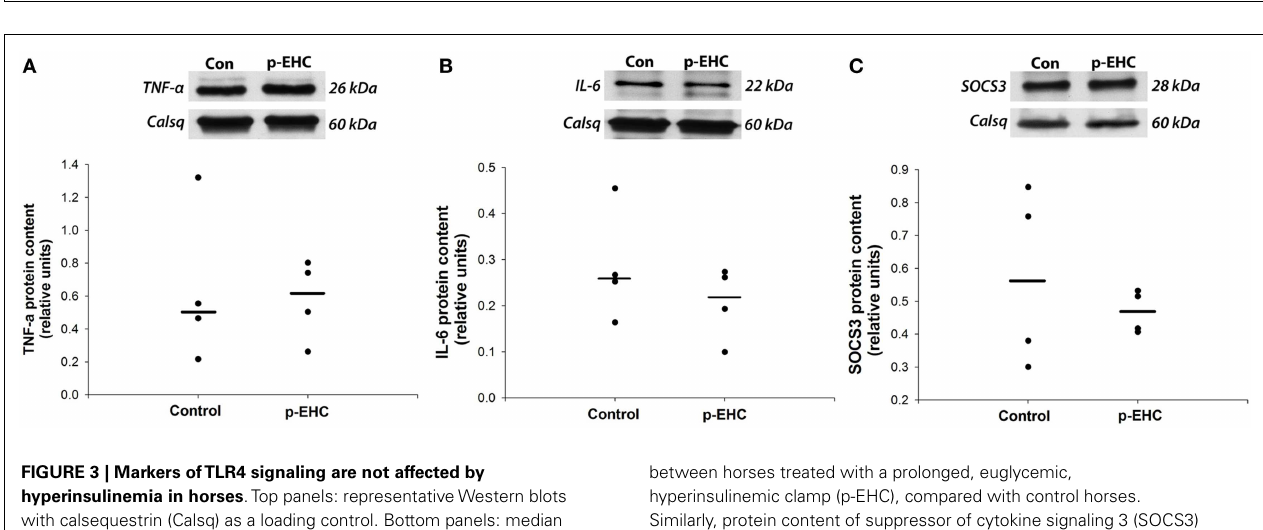
FIGURE 3 | Markers ofTLR4 signaling are not affected by hyperinsulinemia in horses .Top panels: representativeWestern blots with calsequestrin (Calsq) as a loading control. Bottom panels: median myocardial protein expression of the pro-inflammatory cytokines tumor necrosis factor-alpha (TNF- α ) (A) and interleukin-6 (IL-6) (B) do not differ